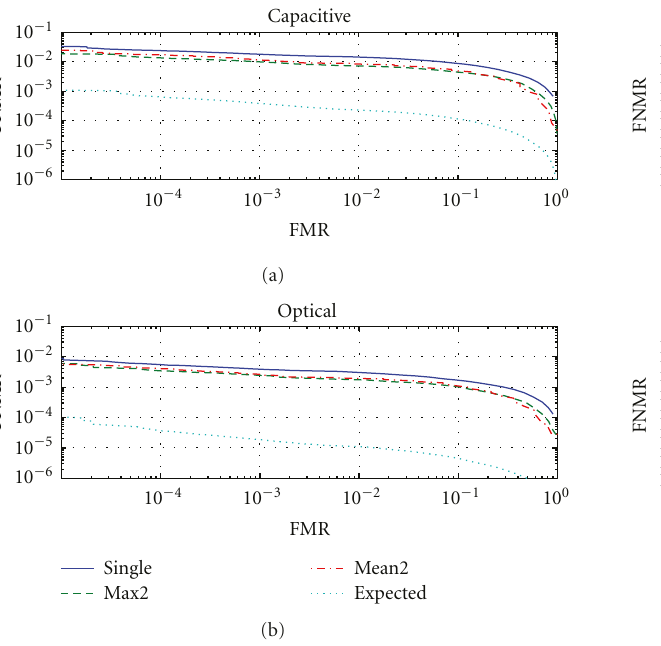
Figure 5: DET curve for the capacitive sensor (a) and the optical sensor (b) based on the balanced database. The solid line represents the FMR/FNMR tradeo ff for a single attempt. The dashed lines represent the performance based on the maximum comparison score of 3 attempts (max3); the dash-dotted lines represent the performance for the mean comparison score across 3 attempts (mean3). The dotted curve represents the expected FMR/FNMR tradeo ff assuming constant false nonmatch and false match probabilities for each